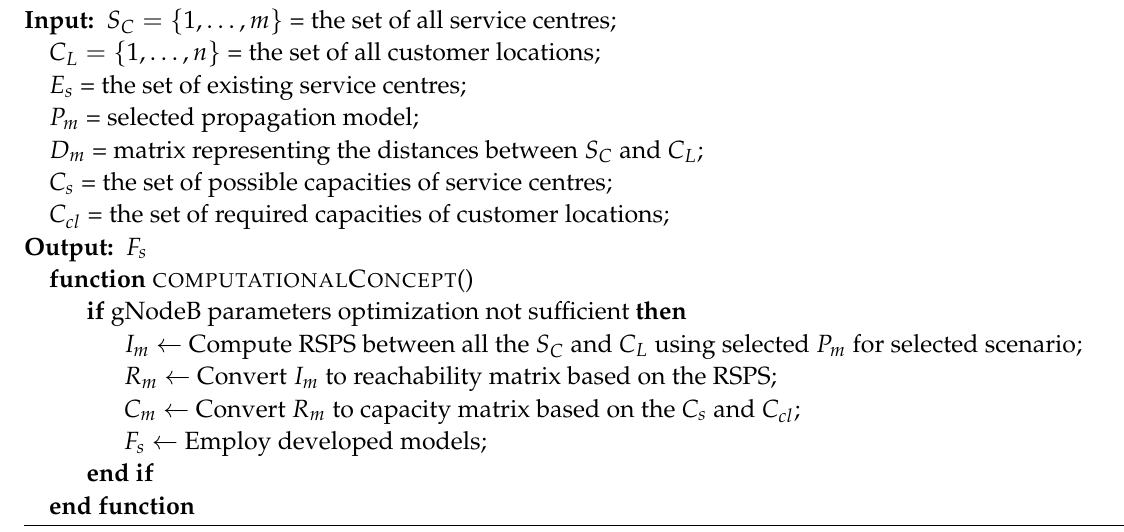
Algorithm 1 The algorithm representing the whole computational concept to get the best locations to deploy service centres (gNodeB)